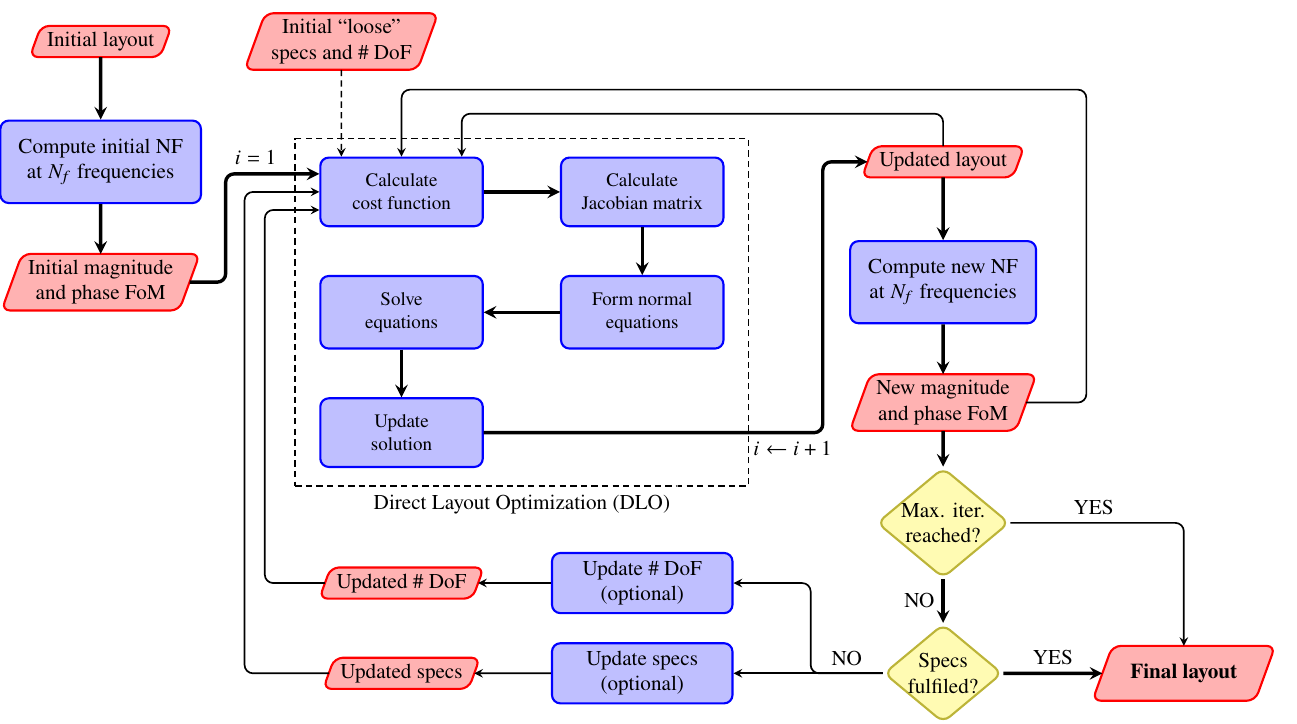
Figure 2. Schematic flowchart of the proposed DLO for a general NF synthesis based on optimization of the relevant NF